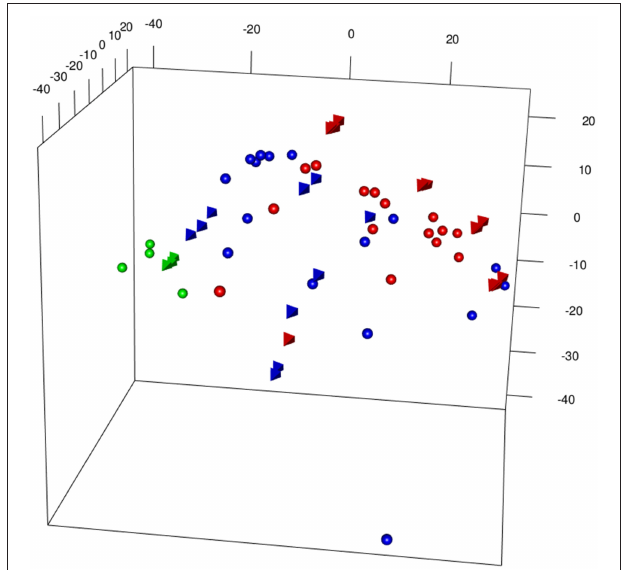
FIGURE 3 | 3DPCA of merged samples from Inflating and Exhausted models’ data sets following batch effects removal between different microarray platforms (spheres: Affymetrix, Exhaustion study, tetrahedron: Illumina, Inflation study). The plot is showing overall distribution of Naive (green), Non-Inflating and Non-exhausting (blue), and Inflating and Exhausting (red) samples using the total common set of expressed genes ( ∼